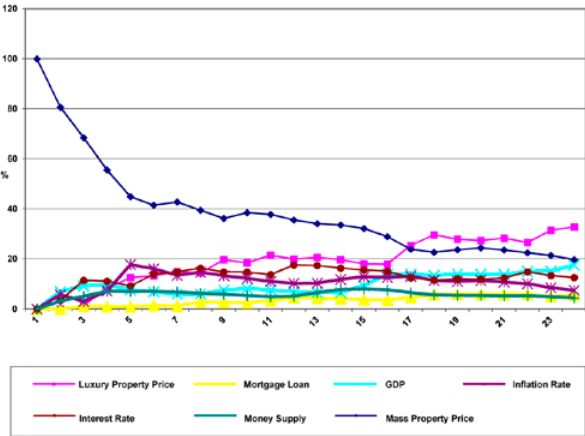
Fig. 7. Variance decomposition of mass residential